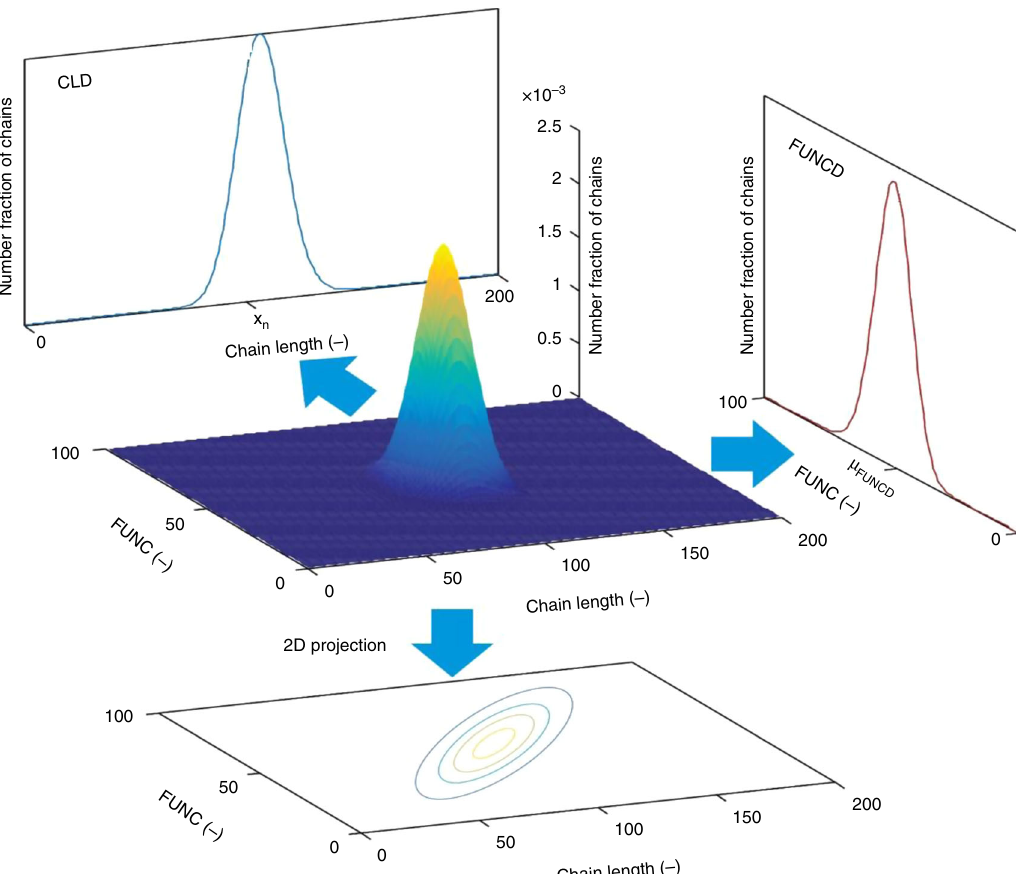
Fig. 2 Principle of in silico generated functionality-chain length distribution (FUNC-CLD). This is illustrated for a theoretically perfect functionalization chemistry (no side reactions and a fast initiation stage) starting with equimolar amounts of functional and non-functional comonomer and aiming at a target degree of polymerization (DP) of 100; middle: FUNC-CLD in 3D view; bottom FUNC-CLD as a 2D projection. The bivariate FUNC-CLD highlights the fraction of chains with a given chain length (CL) and a given number of functional monomer units (FUNC); for this ideal case most probable are chains with a length of 100 and a FUNC of 50; also shown are the two marginal distributions that can be constructed out of FUNC-CLD by integration over CL or FUNC: are also included: for CLD this is the number average chain length ( x n ) and for FUNCD the average functionalization ( μ FUNCD It follows from Fig. 3a that a slower incorporation of C2MestOx (dashed lines; closed symbols) is obtained in the copolymerization with MeOx, despite the higher homo- propagation rate coef fi cient for this comonomer (1.66 10 -1 (C2MestOx) vs. 1.45 10 -1 (MeOx) L mol -1 s -1 ) as also deducible